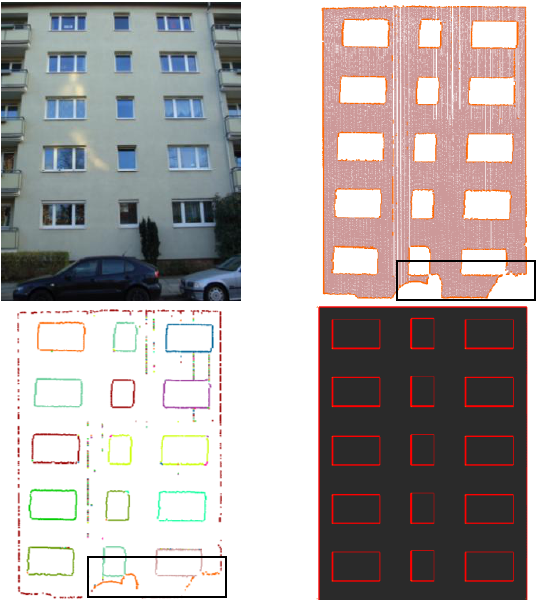
Figure 1: Results of façade reconstruction process for a Wall in area1: (a) a photograph of the relevant wall facade; (b) detected edge points (red); (c) detected individual objects; and (d) the geometric model.